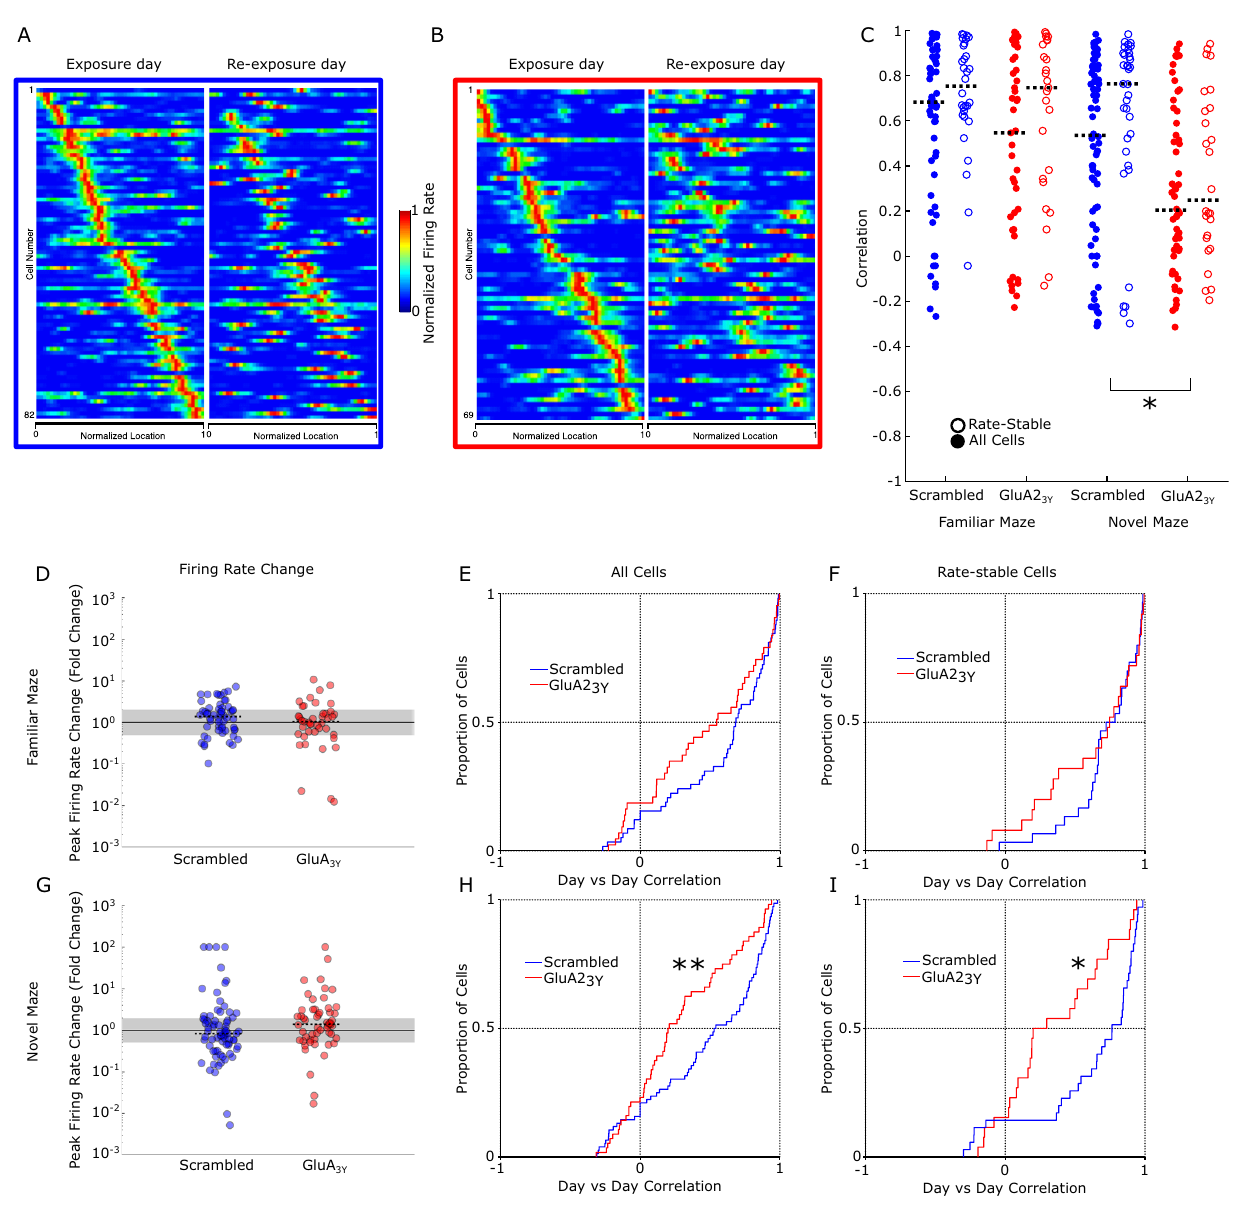
Fig. 3 Blocking AMPA receptor endocytosis impairs place fi eld stability between days in a novel environment. A All matched cells recorded in the linear novel environment on the exposure day (left) and re-exposure day (right) from Scrambled peptide treated rats, sorted by fi ring location on the exposure day show a preserved pattern on the re-exposure day. B All matched cells recorded in the linear novel environment on the exposure day (left) and re- exposure day (right) from GluA2 3Y treated rats, sorted by fi ring location on the exposure day show an impaired spatial pattern on re-exposure. C Day over day place fi eld correlations for all matched cells ( fi lled; Scrambled n = 58 familiar, n = 76 novel, from N = 6 rats blue; GluA2 3Y n = 43 familiar, n = 56 novel, from N = 6 rats red) and rate-stable cells (open; Scrambled n = 30 familiar, n = 35 novel from N = 6 rats; GluA2 3Y n = 25 familiar, n = 26 novel from N = 6 rats). Black bar indicates group median correlation. D , G Firing rate changes from day to day in Scrambled and GluA2 3Y peptide treated rats on the familiar and novel maze. Median fi ring rate changes were minimal in all conditions. Gray indicates rate-stable cells, with rate changes between 0.5 and 2. E , H Day over day correlation distributions in the familiar ( D ) and novel ( G ) linear mazes, with peptide (red) and Scrambled (blue) treatment. GluA2 3Y treated rats had signi fi cantly reduced correlations relative to Scrambled treatment in the novel environment. F , I Day over day correlation in rate-stable cells in the familiar ( E ) and novel ( H ) linear mazes, with peptide (red) and Scrambled (blue) treatment. GluA2 3Y treated cells were signi fi cantly less correlated in the novel environment, even in rate-stable cells. * p < 0.05, ** p < 0.01, k-s test for cumulative distribution or Mann – Whitney U follow-up pairwise comparisons (two-tailed). Error bars represent ± endocytosis inhibition altered the dynamics of place fi eld for- the peptide inhibitor GluA2 3Y , a validated and speci fi c inhibitor mation in a novel environment. Although we demonstrated of LTD expression mechanisms, blocked a novelty induced pathway-speci fi c reduction in fEPSP magnitude in response to decrease in evoked fEPSPs in the hippocampus, blocked facilita- novelty exploration, we blocked AMPA receptor endocytosis tion of inhibitory avoidance by contextual exposure, and throughout the brain while recording fi eld potentials and CA1 impaired the maintenance of place fi eld locations on re-exposure place fi eld activity. As the behavioral effect of systemic treatment to a novel environment. In addition, acute AMPA receptor